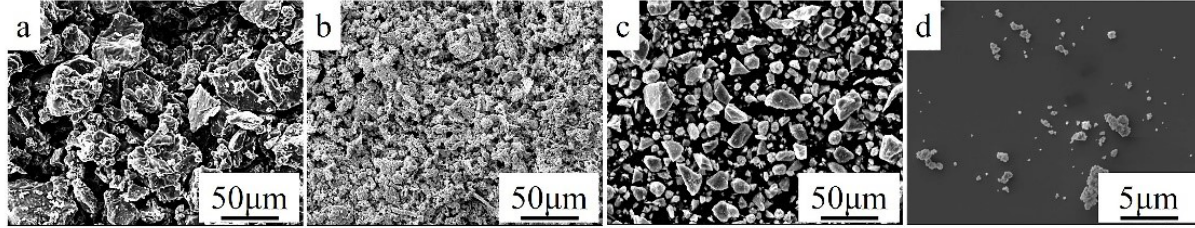
Figure 1: The SEM images of Ti-Si-Mo powder mixtures before and after ball milling: (a) Ti powders before ball milling; (b) Mo powders before ball milling; (c) Si powders before ball milling; (d) Ti-Si-Mo powders after ball